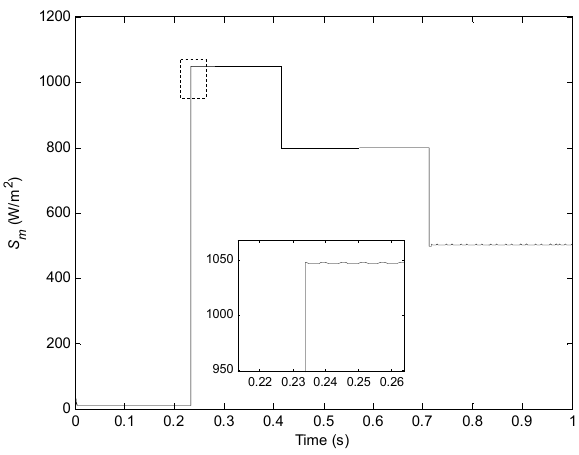
Figure 12. Assumed irradiance curve in first simulation